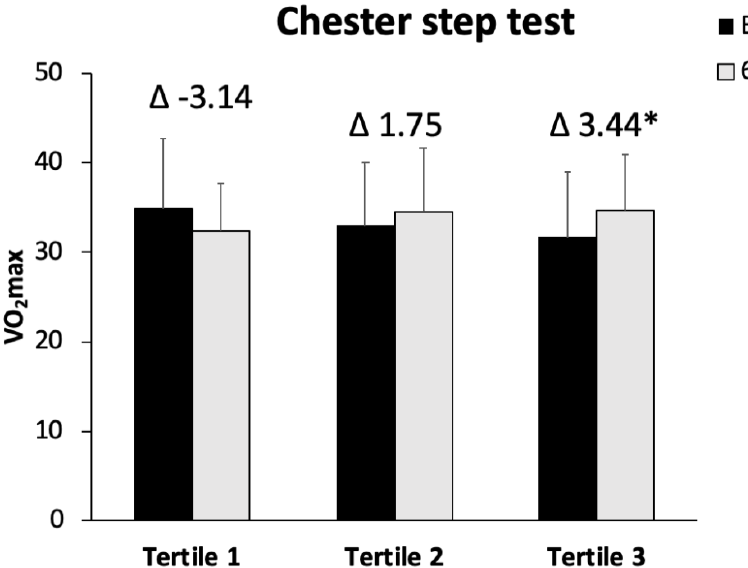
Figure 3. Values are the mean ± SD. Difference in means of IFC classified in tertiles was tested with one-factor ANOVA and Bonferroni’s post hoc analysis when variables followed a normal distribution or with Kruskal–Wallis test for non-normally distributed variables. * Differences with respect to tertile 1.